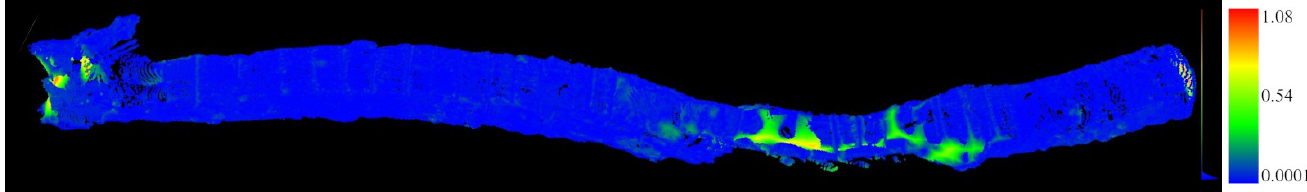
Figure 18. The image was created using the CloudCompare software. A comparison of the reference point-cloud with the simulated point-cloud was performed based on the integrated tool Cloud-to-Cloud Distance. At the right edge of the image a scale with the absolute deviation in meters is shown. This ranges from 0.00 (blue) to 1.08 m